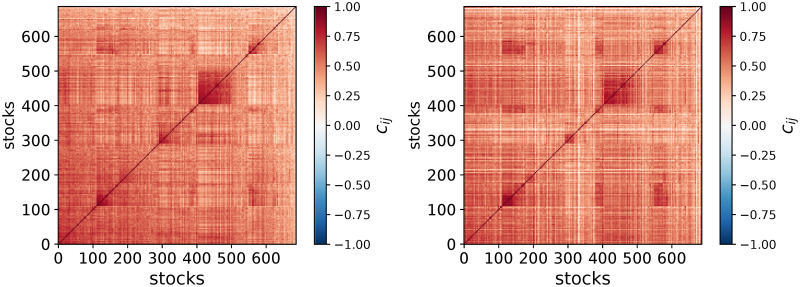
Correlation matrix of US equities price returns in the 2008-01-23 to 2008-11-04 (left plot) and in the 2008-11-05 to 2009-08-24 period (right plot).The elements of both panels are ordered according to the in-sample HCAL dendrogram of the first period.